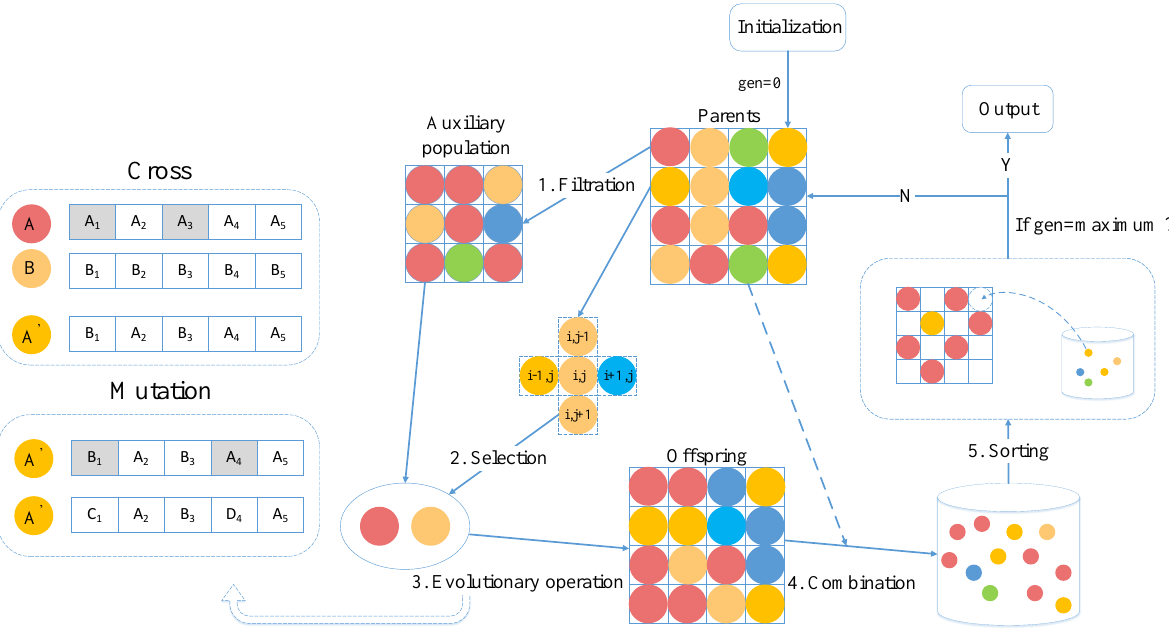
Figure 2. The structure and procedure of